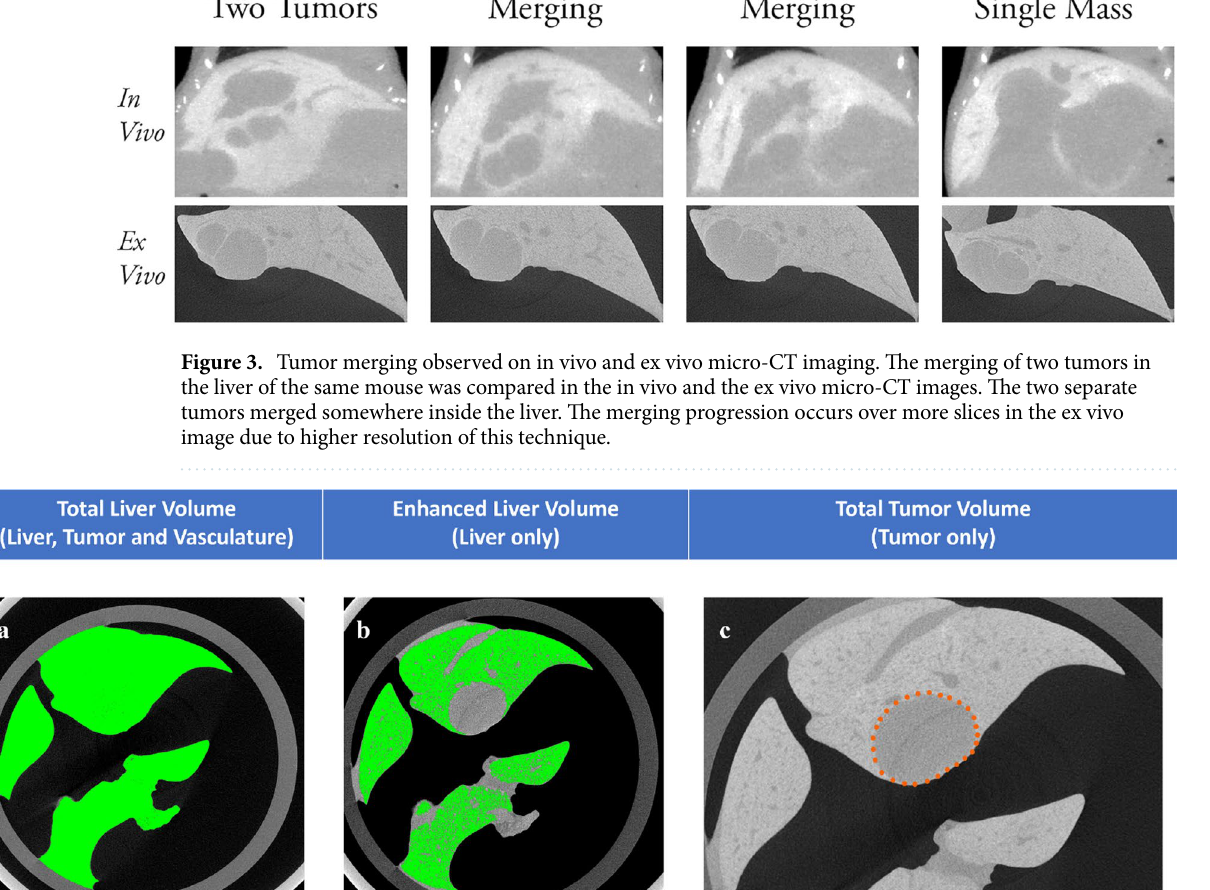
were situations where two tumors grew close together, but the in vivo images only show one large tumor mass because of the lower resolution. The same tumors in the ex vivo images appeared as separate tumors extremely close together but separated with a thin line of enhanced liver tissue because of its higher resolution. There are also tumors that eventually grow into each other and merge to form one. This merging process can be observed in both images. The two merging tumors in the ex vivo image was shown in detail over a depth of 10 mm in the liver with an initial thin separation that was slowly closed by the growth of the two tumors until they merged together (Fig. 3 bottom row). The in vivo image progresses through the merging process of the same tumors faster; in fewer slices representing the same liver thickness, the two separate tumors fused into one mass (Fig. 3 top row). The in vivo image was able to show the merging process inside the liver but lacked detail that was only observable in the ex vivo image. Tumor volume measurement. The total liver volume includes the entire enhanced liver along with the tumors and the vasculature. The enhanced liver parenchyma could be easily segmented. However, the unenhanced region included the tumours, but also the vasculature. The vasculature was estimated from one mouse, and the volume was applied to the entire group, as they were age- and sex-matched. One mouse grew a single well-formed tumor that was completely enclosed within the liver, and was therefore chosen to estimate the liver vasculature. The measured volumes are shown in Fig. 4. The entire liver volume measured 1444.98 mm 3 (Fig. 4a) and the enhanced liver parenchyma measured 902.75 mm 3 (Fig. 4b). The difference was 542.23 mm 3 but this value also included the liver vasculature, so the tumor nodule in the liver was manually measured and the total tumor volume was 51.46 mm 3 (Fig. 4c). The total vasculature volume (Eq. 1) was calculated to be 490.77 mm 3 and the percentage of the total tumor burden (Eq. 2) was calculated to be 3.56%. For all the other mice, the adjustment was made by subtracting the vasculature volume of mouse 2 (490.77 mm 3 ) from their measured enhanced liver volume shown in (Eq. 2), and the percentage of the total tumor burden for each mouse was calculated. The measured tumour volumes for selected tumours from the in vivo scans, along with the ex vivo volumes and total tumor burden are given in Table 2 for mice that received the Fenestra VC agent, and in Table 3 for the mice that